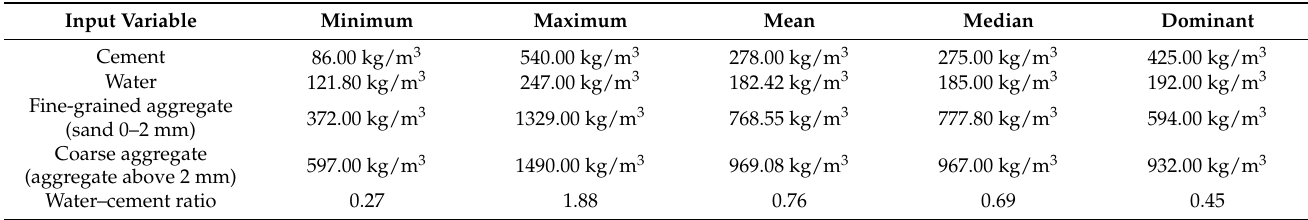
Table 2. Value ranges of database input